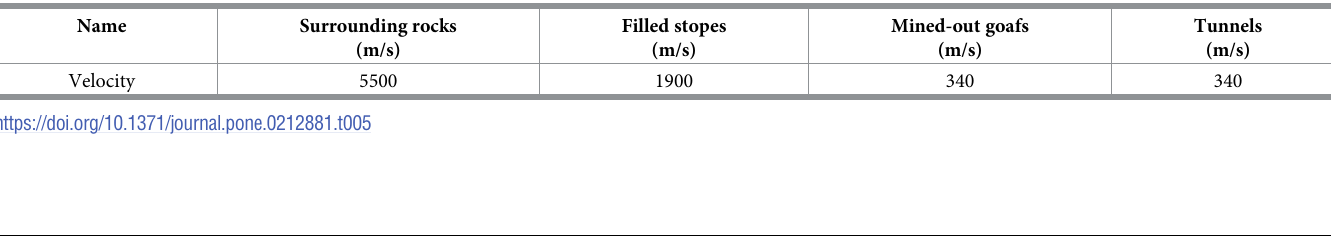
Table 5. P-wave velocities of the Mine Model.